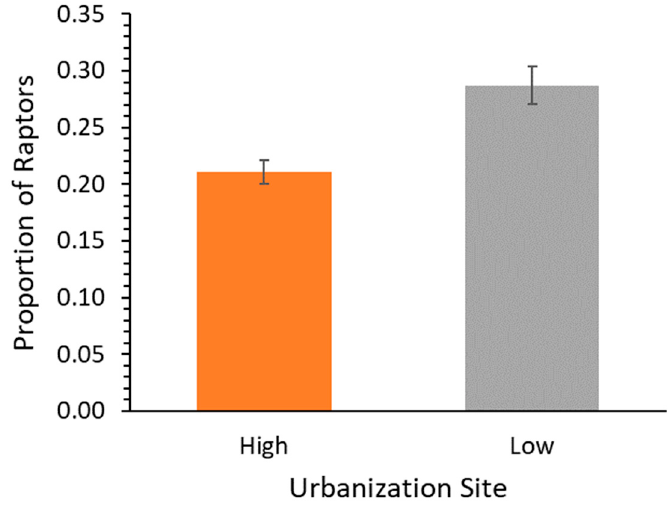
Figure 4. Average total proportion of raptors ( ± 1 SE) in high ( n = 6) and low ( n = 6) areas of urbanization in the Great Trinity Forest, Dallas, TX, USA over the 10-week study period.